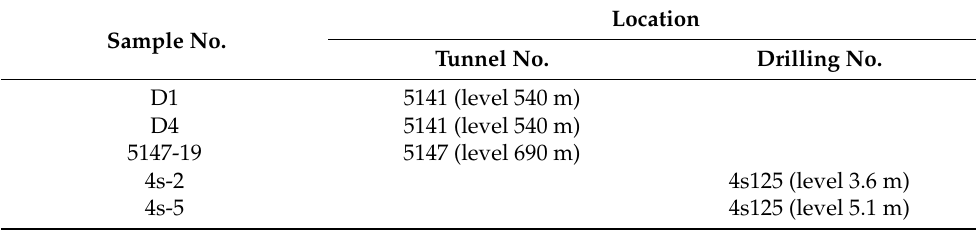
Table 1. Sample locations of Tongkuangyu granodiorite porphyry. Sample